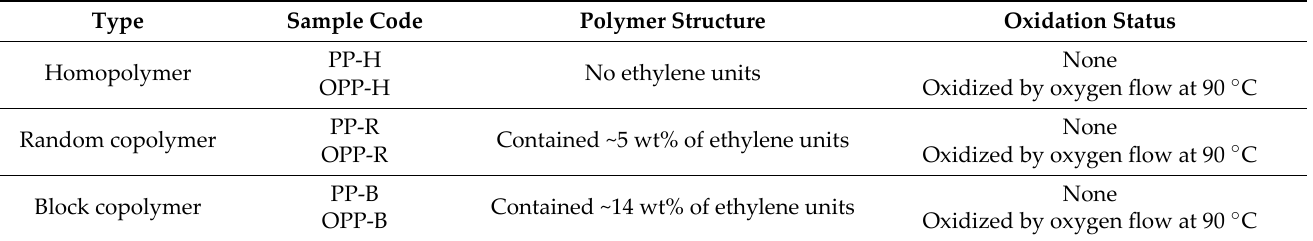
Table 1. Polypropylene granule samples used in this